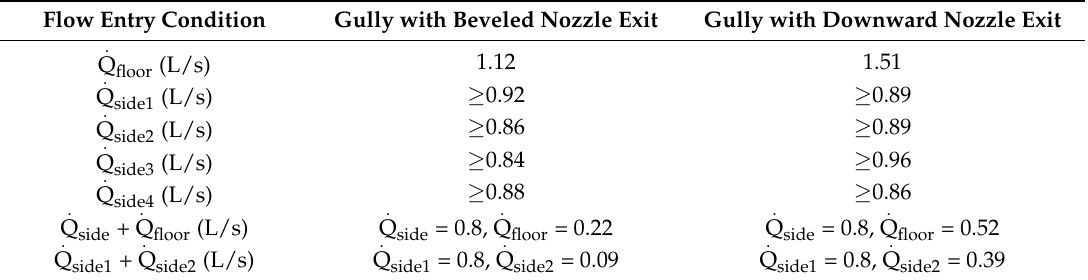
Table 3. Maximum flow rates with various entry